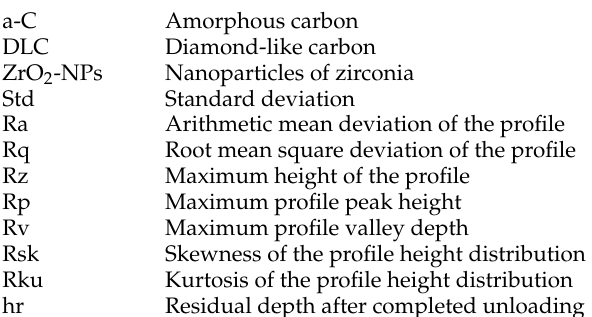
Figure S1: FESEM images of the residual W-NPs on the worn a-C surfaces after tribo tests; (b) show the magnified details of the region marked in the Figure S1a; Figure S2: The FESEM images of the worn a-C surfaces when tested with W-NPs. (b,c) show the details of the region marked in Figure S2a; Figure S3: The topography and (b) line profile from the white line of the worn a-C surfaces when tested with W-NPs; (c) The wear rates of a-C lubricated with pristine PAO and PAO with W-NPs and ZrO 2 -NPs; Figure S4: The load − displacement curves in the nano-indentation tests performed on the (a) as-deposited a-C surface and the worn a-C surface when lubricated with (b) pristine PAO oil and (c) PAO with ZrO 2 -NPs, respectively; Figure S5: (a) The nano-indentation results of Cr doped a-C coating; (b) The COF of Cr doped a-C contacts under the lubrication of pure PAO and ZrO 2 -NPs dispersion; (c) The wear rates of a-C and Cr-doped a-C under the lubrication of pure PAO and ZrO 2 -NPs dispersion; Figure S6: Digital images of dispersion of ZrO 2 -NPs in PAO oil. The time for each picture is noted on 2 h; (d) 3 h and (e) 12 h. Concentration of ZrO 2 -NPs: 1 wt